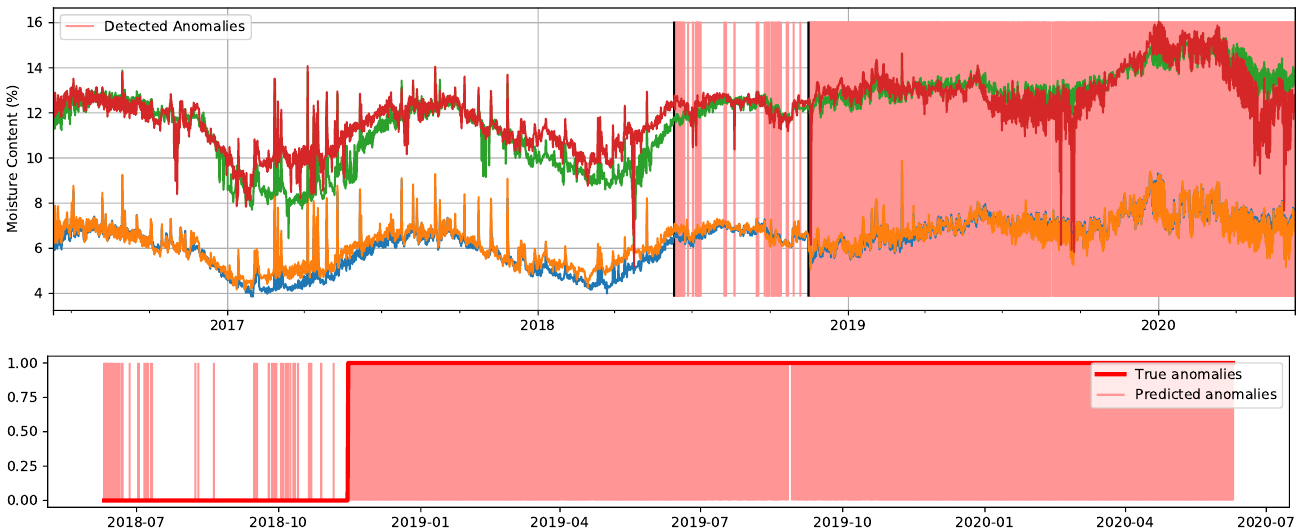
Figure 15. Detected anomalies when using the cluster-based LOF method with the original signals and the true contamina- tion value (78.4%). Predicted anomalies are marked in light red. In the top figure, two black lines determine the start of the test set and, afterwards, the moment when the A/C failed. In the bottom figure, corresponding only to the test set, true anomalies are delimited by the red